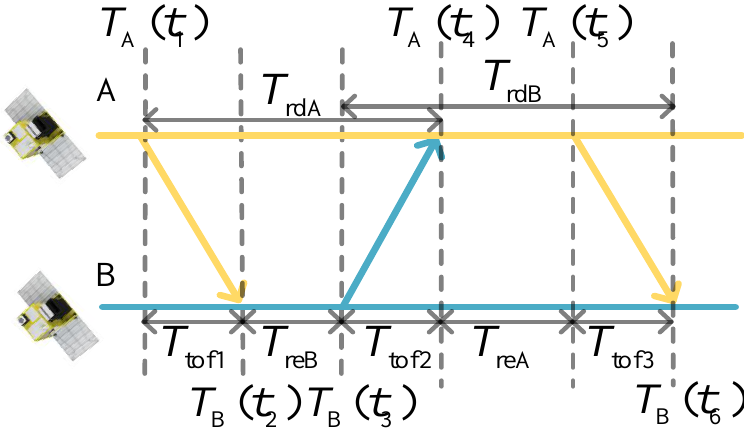
Figure 1. Principle of asymmetric double-sided two-way ranging.